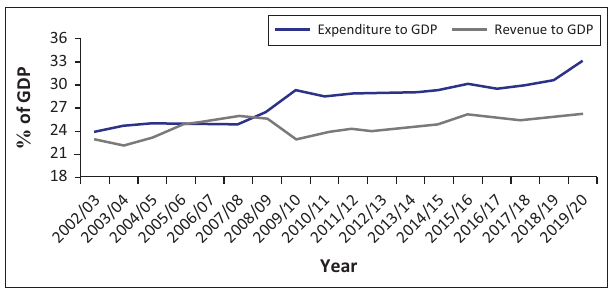
FIGURE 1: Expenditure and